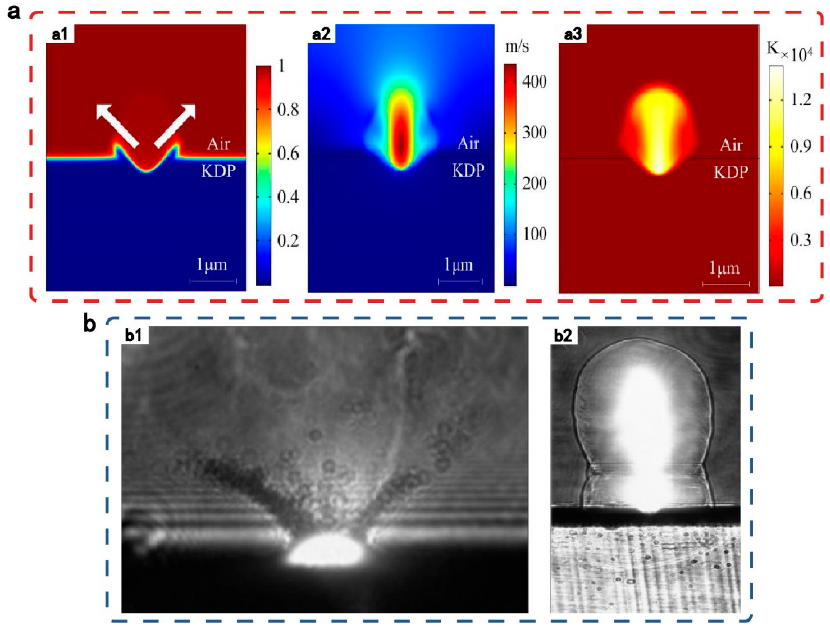
Figure 23. Transient dynamic behavior induced by laser damage on the surface of KDP crystal with conical crack defect. ( a ) Multi-physics coupling simulation result with a1 crater morphology, a2 vapor velocity distribution, and a3 temperature distribution of local laser damage area; ( b ) Experimental images captured by the system in the laser damage micro-region with b1 material ejection and b2 plasma expansion [89].